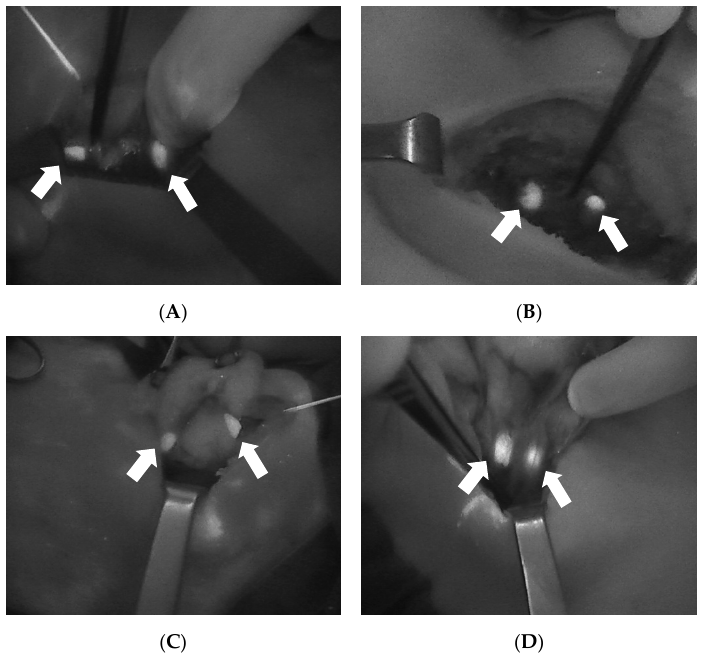
Figure 2. Four intraoperative images showing the autofluorescence of the parathyroid glands (arrows) as detected with Fluobeam LX ® (Fluoptics©, Grenoble, France). ( A ): Two PGs after right lobectomy. ( B ): Two PGs after left thyroid lobectomy. ( C ): Two PGs after superior pole dissection and the medialization of the left thyroid lobe. ( D ): Two PGs after superior pole dissection and the medialization of the right thyroid lobe. PGs, parathyroid glands.